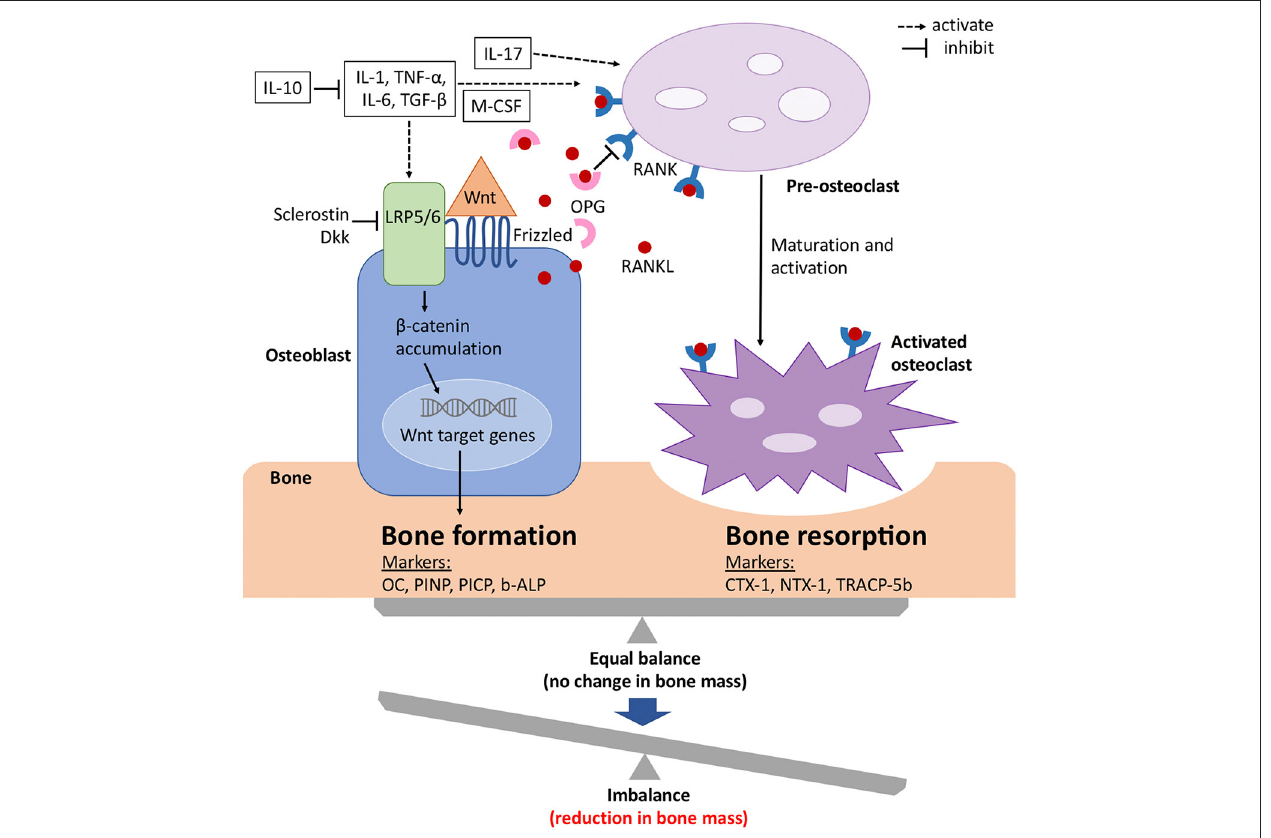
FIGURE 2 | Signaling mechanisms with balance of bone formation and resorption in bone metabolism. The balance between bone formation and bone resorption is largely regulated by the Wnt/ β catenin pathway and the RANK/RANKL/OPG axis. Wnt protein binds to its co-receptors Frizzled and LRP5/6 on the surface of osteoblasts, which leads to the stabilization and accumulation of β -catenin in the cytoplasm, before it translocates to the nucleus where it regulates target genes and induces bone formation. This pathway can be inhibited by sclerostin and members of the Dkk protein family. RANKL binds to its receptor RANK, which is expressed on pre-osteoclasts. This induces the activation of several transcription factors and in turn osteoclast differentiation and maturation. OPG, which is a soluble decoy receptor and also secreted by osteoblasts, can bind to RANKL and thereby inhibits bone resorption. Under physiological conditions, OPG and RANKL are in equilibrium and preserve bone homeostasis. Several proinflammatory cytokines and growth factors (white boxes) stimulate and upregulate RANKL expression and mediate osteoclast maturation and activation. The metabolic state of the bone is reflected by its biochemical products, which also serve as bone turnover markers for either bone formation or resorption. b-ALP, bone-specific alkaline phosphatase; CTX-1, carboxy-terminal cross-linking telopeptides of type I collagen; Dkk, Dickkopf; IL, interleukin; LRP, low-density lipoprotein receptor-related protein; M-CSF, macrophage colony-stimulating factor; NTX-1, amino-terminal cross-linking telopeptides of type I collagen; OC, osteocalcin; OPG, osteoprotegerin; PICP, procollagen type 1 carboxy-terminal propeptide; PINP, procollagen type 1 amino-terminal propeptide; RANK, receptor activator of nuclear factor-kappa B; RANKL, receptor activator of nuclear factor-kappa B ligand; TGF- β , transforming growth factor β ; TNF- α ,